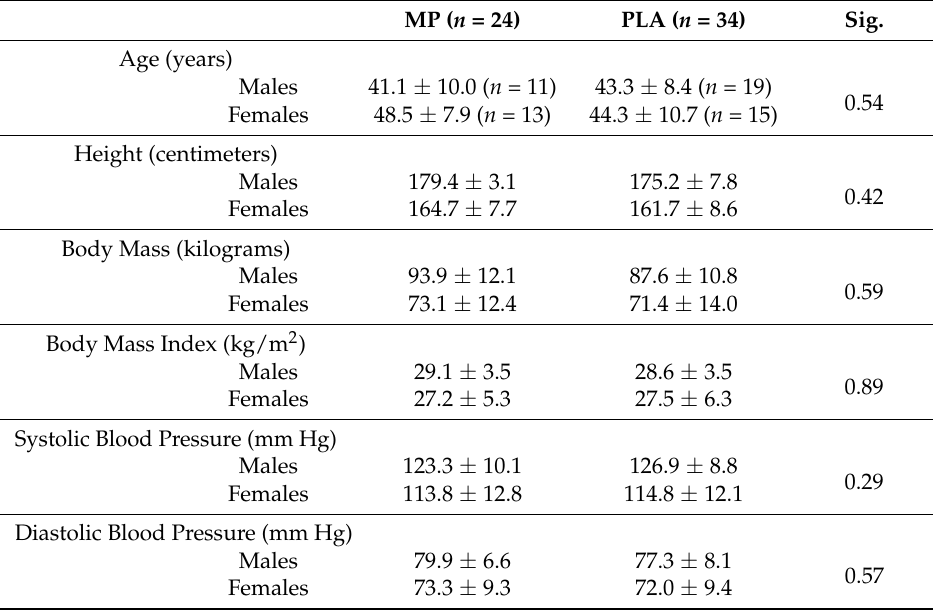
Table 2. Baseline Demographics, WOMAC Scores and Dietary